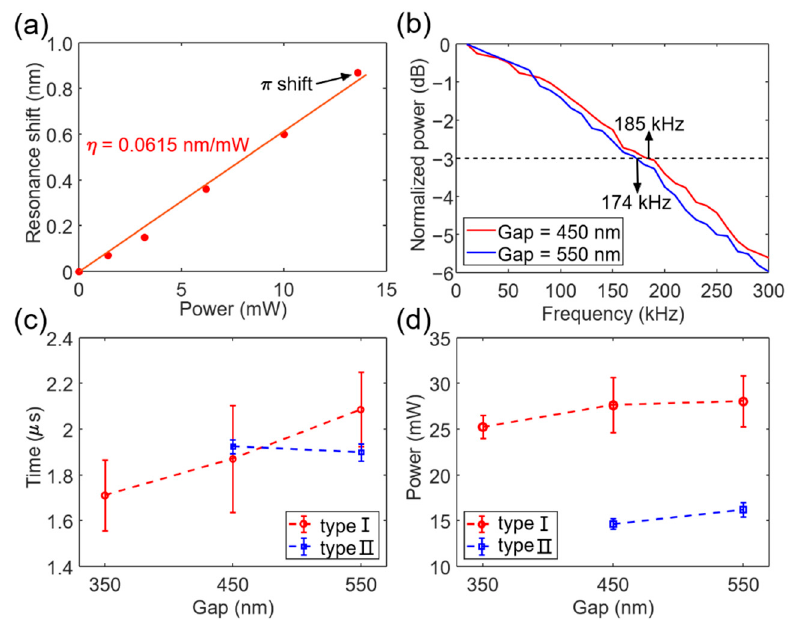
Figure 7. ( a ) Resonance shifts for the interference dips at 1549.75 nm for different heating powers (Gap = 450 nm). ( b ) Measured 3-dB bandwidth for different gaps. ( c ) Measured response time (the average of rise time and decay time) for different gaps. ( d ) Measured power consumption for different gaps.